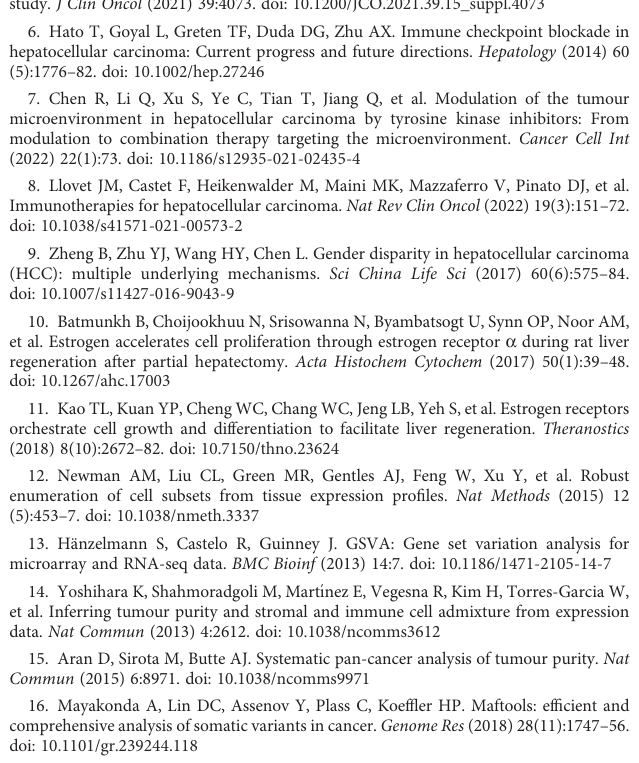
Results of GSEA KEGG functional enrichment analysis in the high-risk and low-risk groups. SUPPLEMENTARY FIGURE 6 Results of HALLMARKER pathway enrichment analysis in the high-risk and low- risk groups. (A-C) The enrichment results of HALLMARKER pathway showed that E2F_TARGETS (A) , G2M_CHECKPOINT (B) and DNA_REPAIR (C) were mainly enriched in high-risk group, while COAGULATION (D) was mainly enriched in low-risk group SUPPLEMENTARY FIGURE 7 Heatmap shows that most immune checkpoint-associated genes are overexpressed in high-risk groups. SUPPLEMENTARY FIGURE 8 Drug sensitivity prediction in the training set. (A-F) The results of drug sensitivity analysis showed a higher risk score was related to lower IC50 among antitumor drugs, such as Midostaurin (A) , Salubrinal (B) , Tipifarnib (C) , Etoposide (D) , Embelin (E) and Doxorubicin (F)